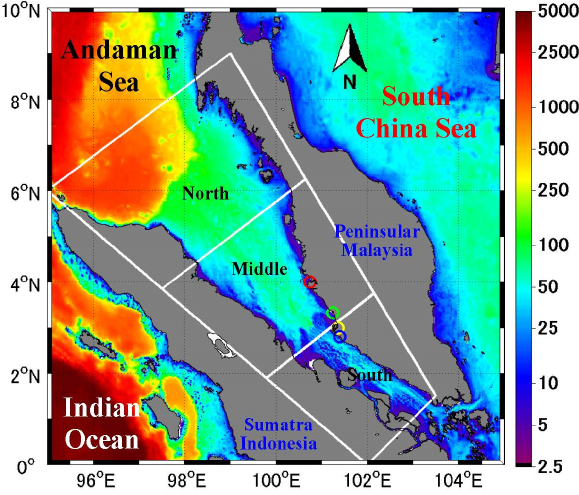
Figure 1. The map of the Strait of Malacca (SM) divided into northern, middle and southern regions. The color scale indicates depth (meters) of the water column. Red, green, yellow and blue circles along the western coast of Peninsular Malaysia indicate the estuaries of the Perak, Selangor, Klang and Langat Rivers,